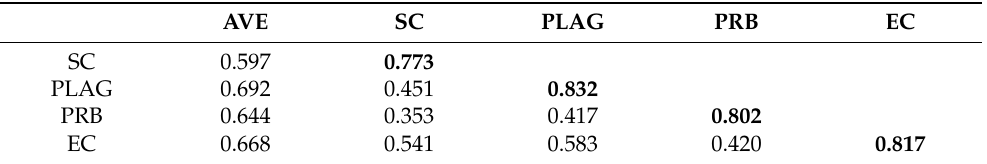
Table 8. Construct validity analysis.